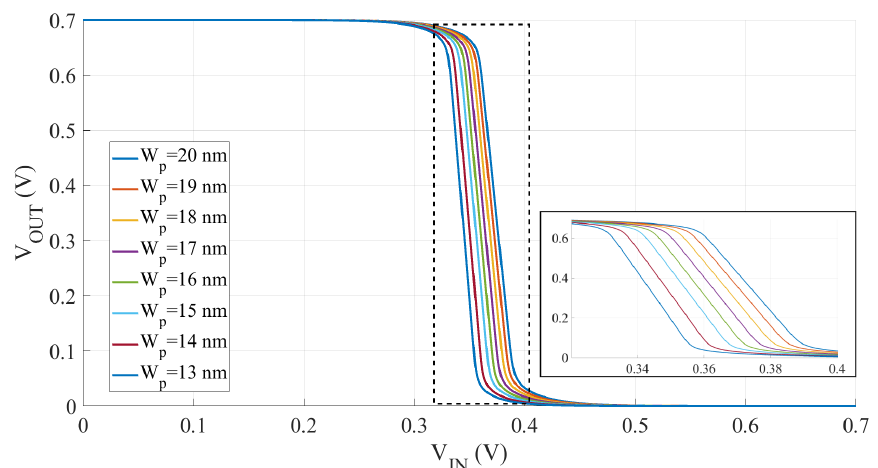
Figure 5. Parametric inverter transcharacteristics V OUT /V IN with different p-type nanosheet width W p and with W n = 20 nm; the inset shows an enlargement of the dashed box portion.